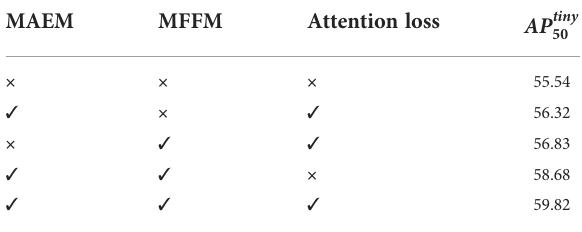
TABLE 3 Ablation study on whole